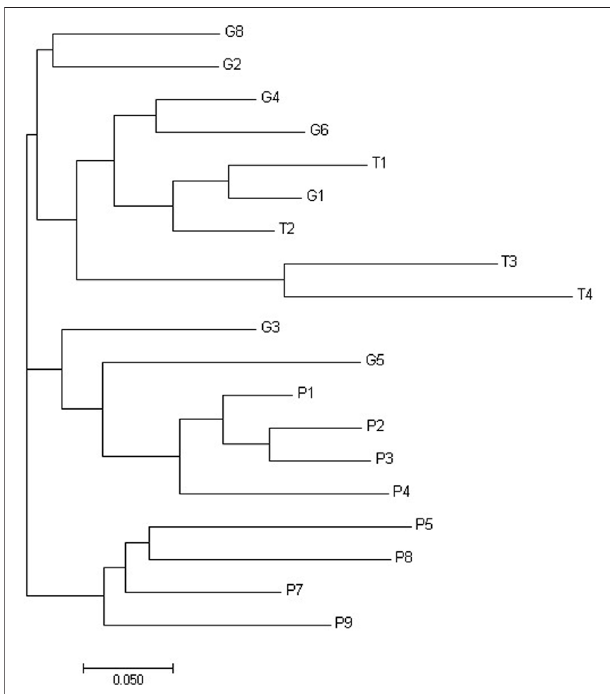
FIGURE 2 | Phylogenetic tree of Da distances of Nei built using the neighbor-joining method for the properties of Curraleiro Pé-Duro cattle.